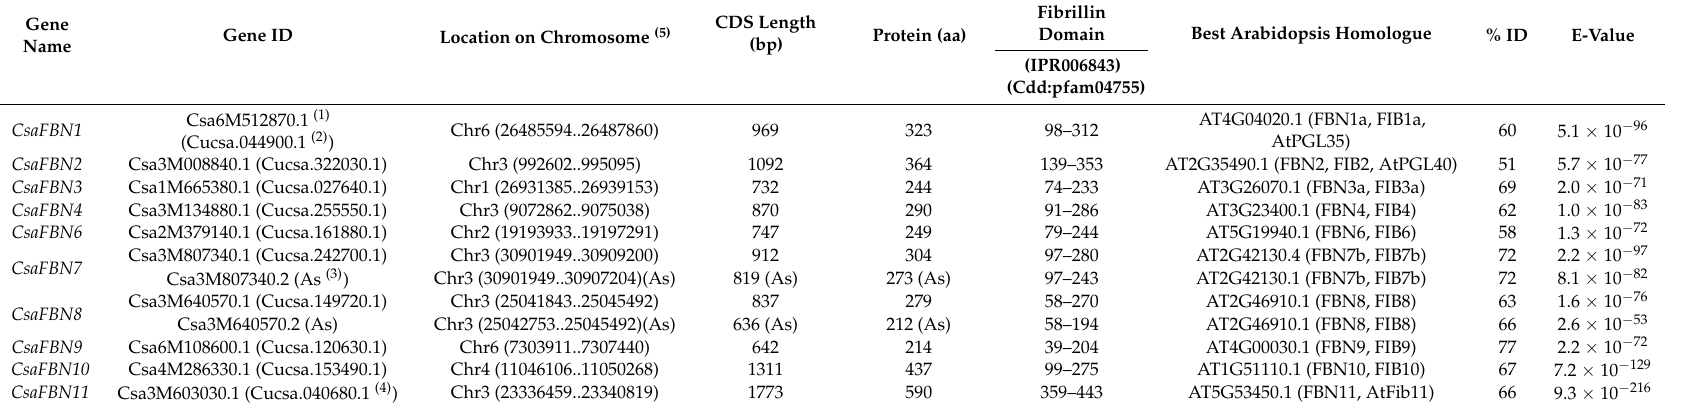
Table 1. FBN genes identified in cucumber